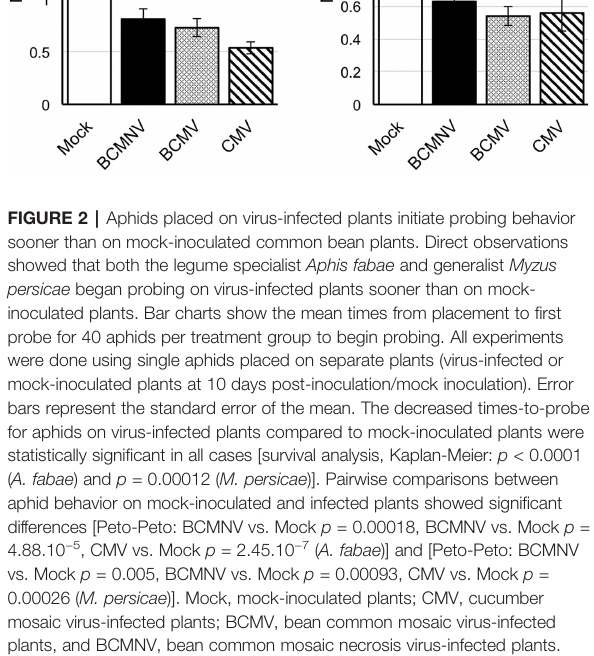
TABLE 2 | Probing and pathway behavior (mean ± SEM) of M. persicae and A. fabae on leaves of virus-infected and mock-inoculated (Mock) bean plants over an 8-h EPG recording. Aphid EPG Parameters (waveform # )